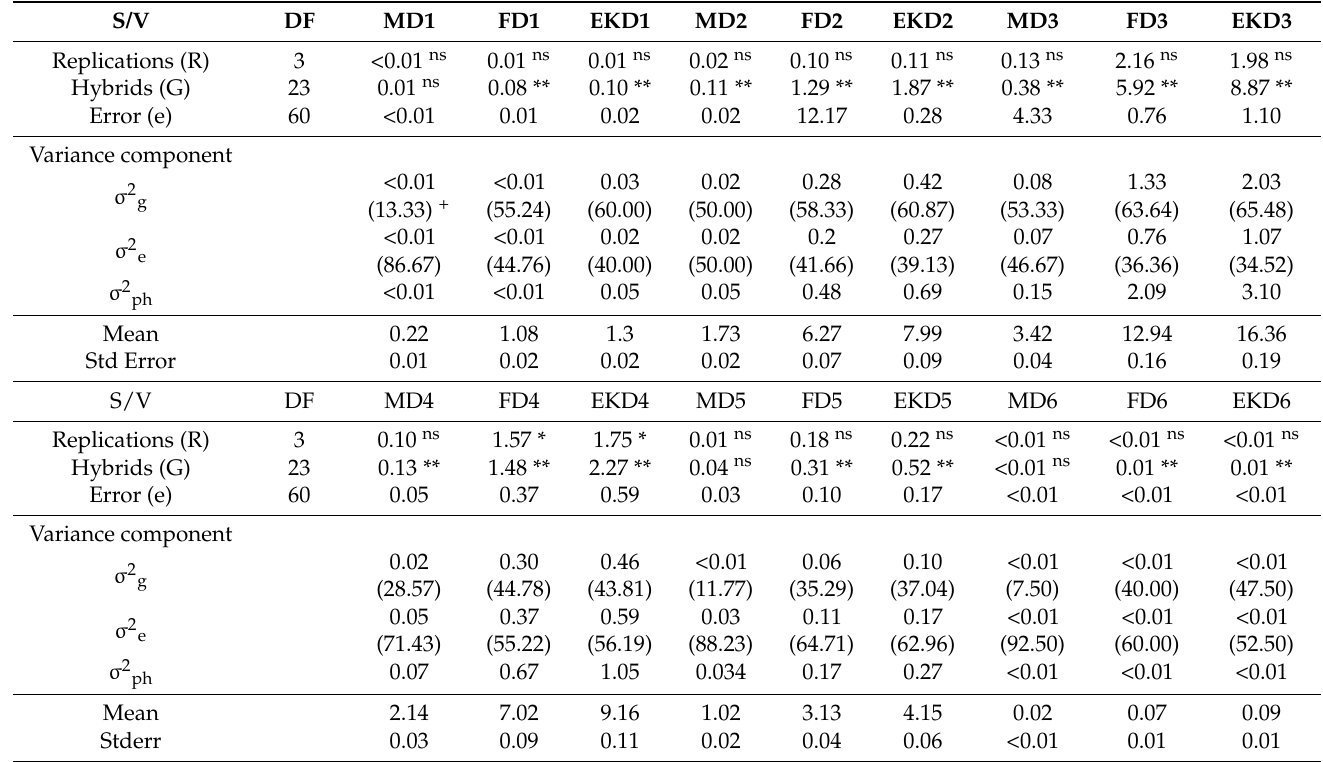
Table 2. ANOVA and variance components for the population of Elaeidobius kamerunicus per spikelet on each day of